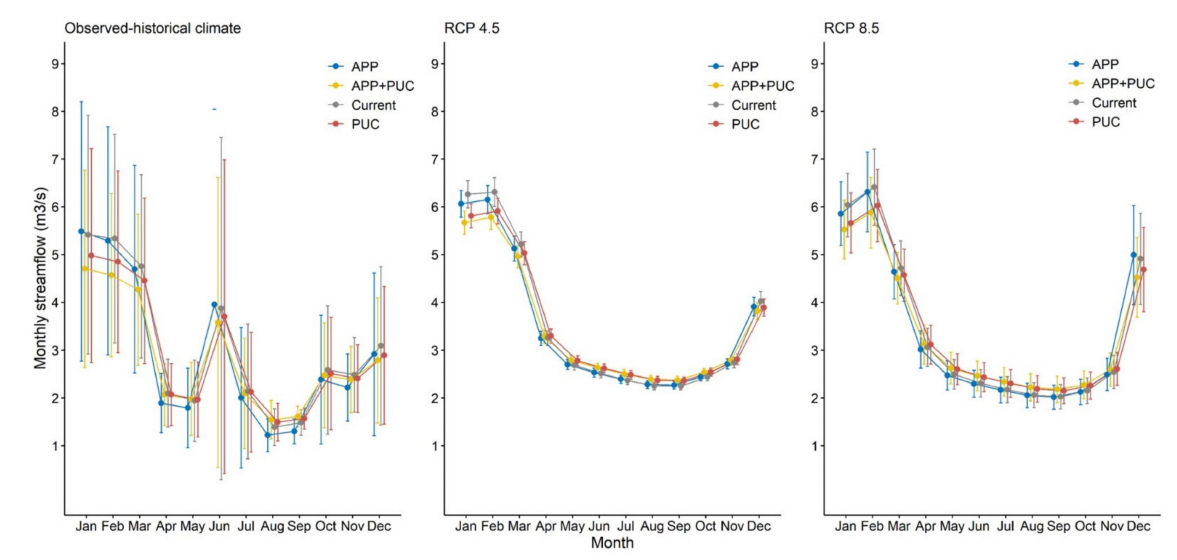
Figure 6. Monthly mean streamflow for each LULC scenario (i.e., Current; APP = riparian restoration; PUC = focal conservation; APP + PUC = combined solution) in each climate condition for the entire simulation period: observed historical = average for each month of the year for the years 2012 to 2019; RCP 4.5 and RCP 8.5 = average for each month of the year for the years 2020 to 2095.